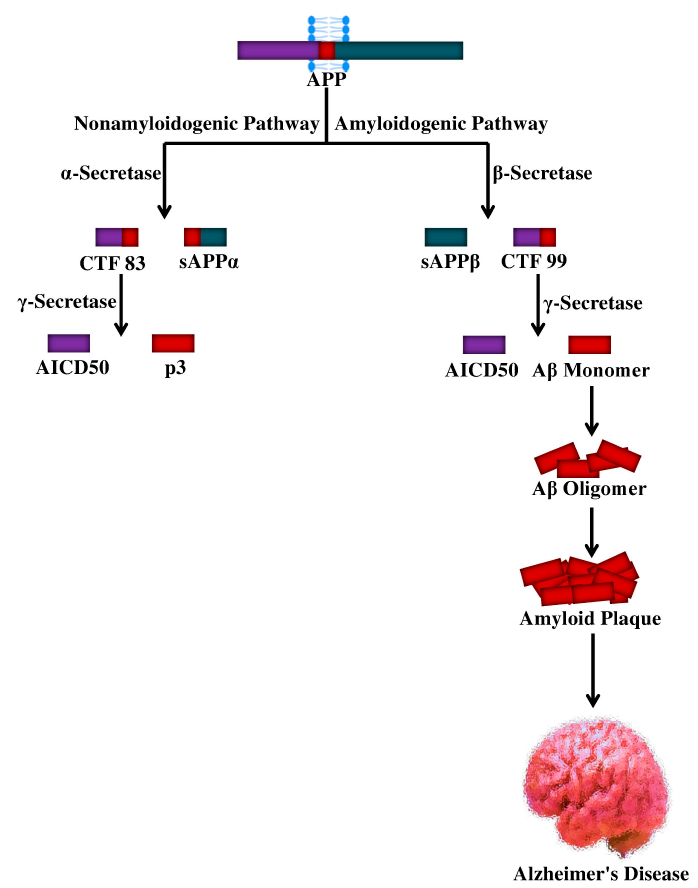
Figure 1. Cellular processing of amyloid precursor protein and the genesis of A β peptide. APP, amyloid precursor protein; sAPP, soluble amyloid precursor protein; CTF, C-terminal fragment; A β , amyloid beta; AICD, APP intracellular domain; p3, peptide p3.